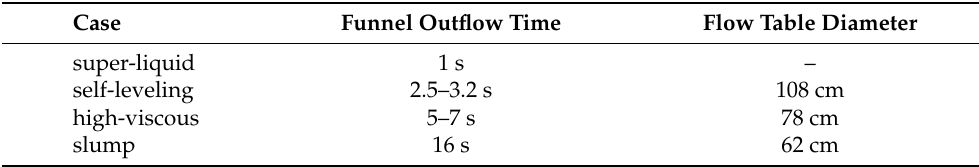
Table 2. Obtained rheological properties of the simulated SFRC mass using simulated funnel flow test and flow table test (with Abram’s cone, the dropping of plate was not simulated).